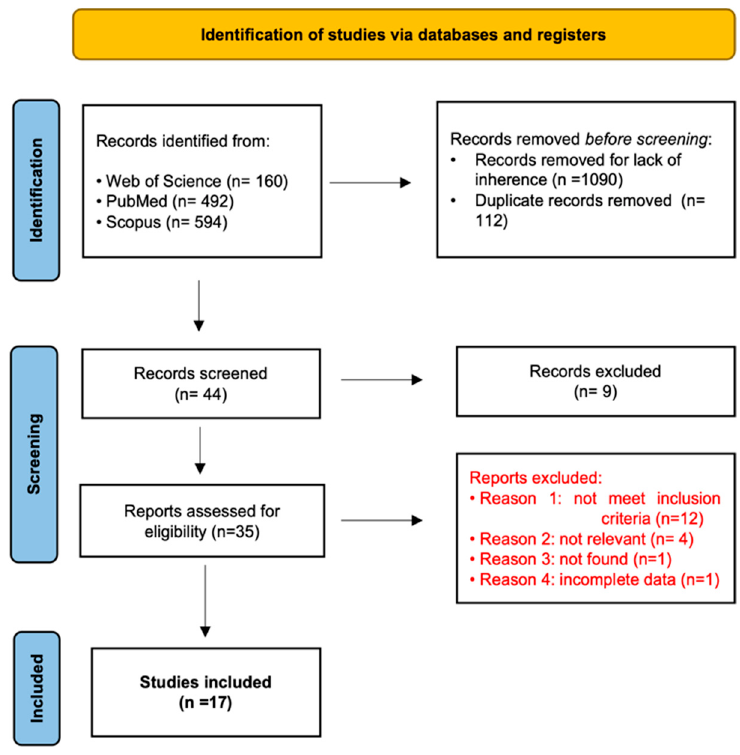
Figure 1. PRISMA flow diagram describing the study selection